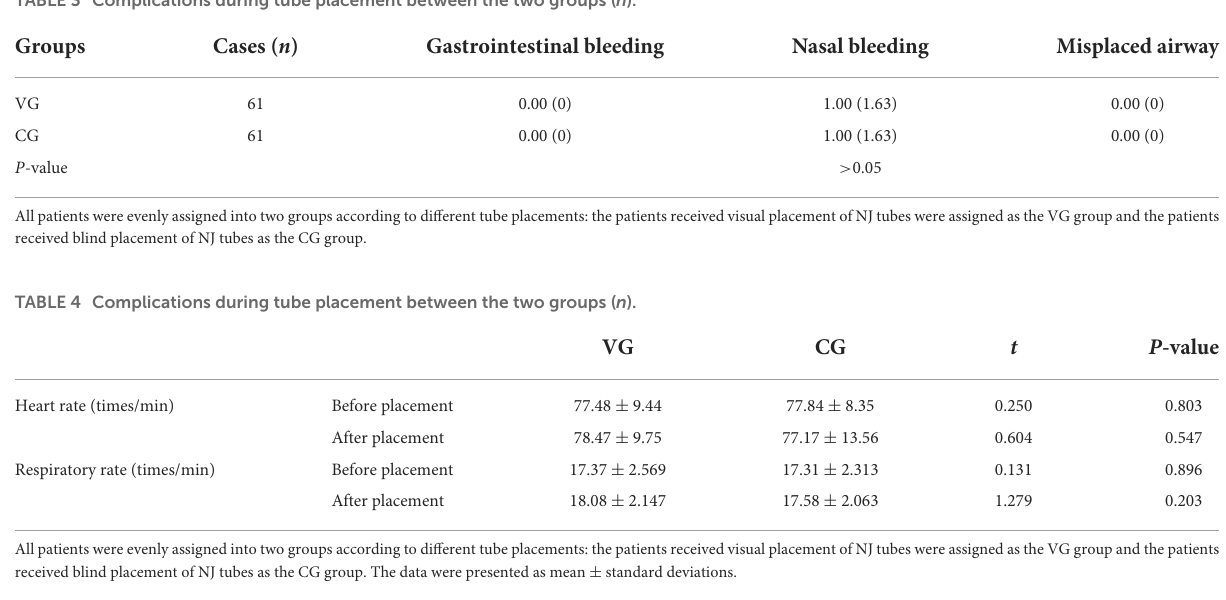
TABLE 3 Complications during tube placement between the two groups ( n ).